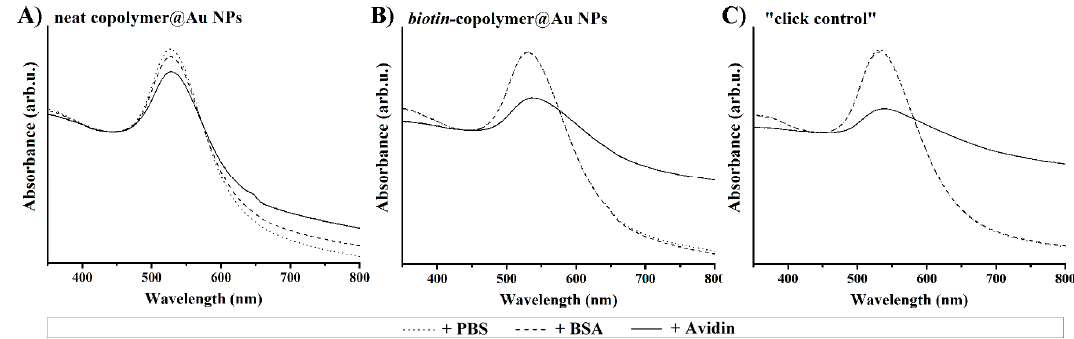
Figure 6. Visible spectra of the colloids in the presence of 10 µ L of BSA and avidin, ( A ) neat copolymer@Au NPs, ( B ) biotin–copolymer@Au NPs, and ( C ) “click control”. PBS was used as dilution control, and used as blank. The spectra were normalized at 450 nm.